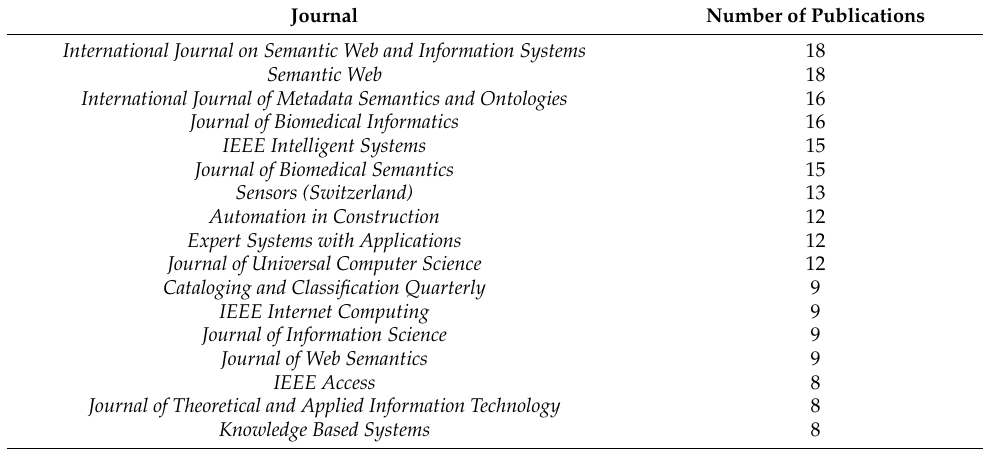
Table 2. Top 15 most relevant